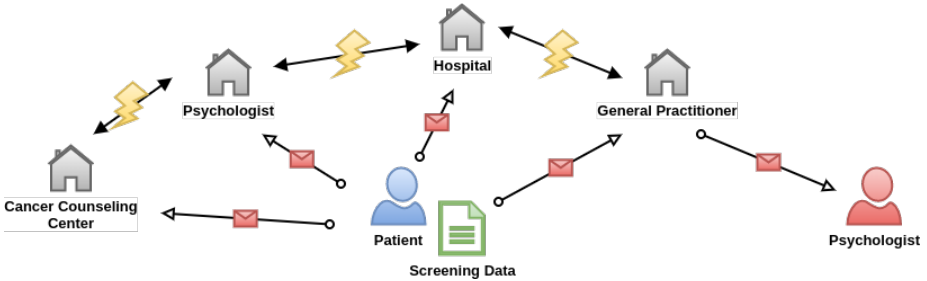
Figure 1. As-Is State of the Application Scenario. The figure depicts the current scenario of data transfer in psycho-oncological treatment. The patient has to submit a paper-based questionnaire to each involved health care provider. These different providers usually do not share data across each other due to the lack of direct communication. Consequently, data are not synchronized and are prone to be incomplete for certain